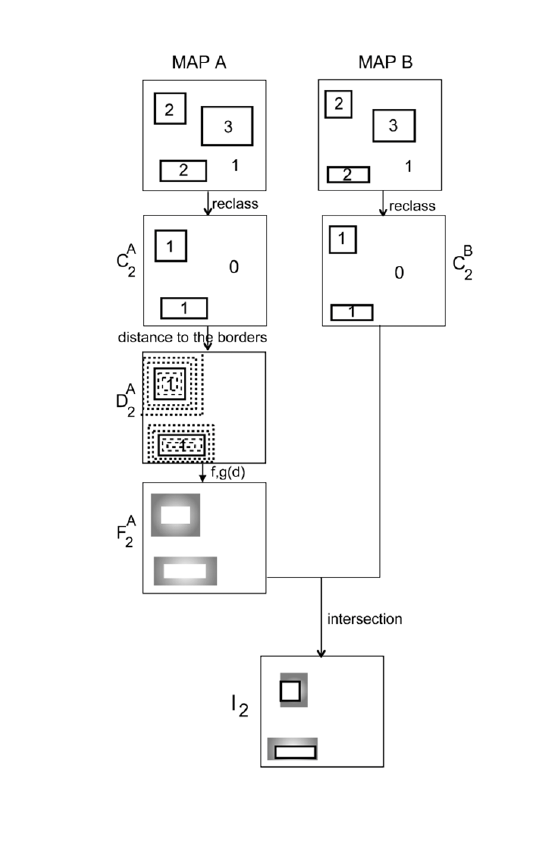
Fig. 1: Flowchart showing the proposed methodol- ogy for comparing